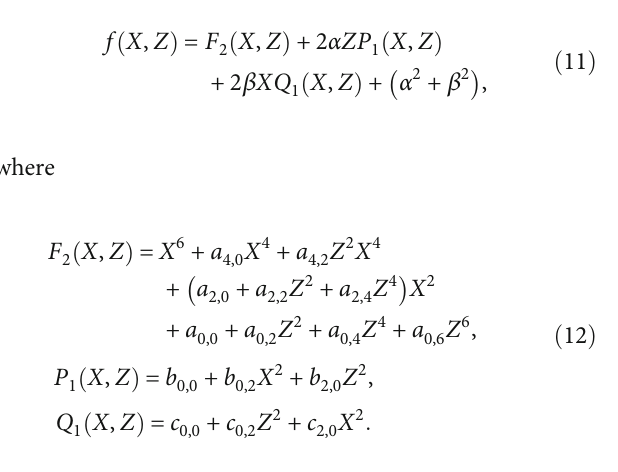
Figure 2: The 3-lump solution u of Equation (1) with the parameter selections m = − 3, n = 2, c = 1, u b = 1 . (a) Perspective view of the wave u ð X , Z Þ , (b) overhead view of the wave u ð X , Z Þ , and (c) the corresponding contour plot 0,2 u ð X , Z Þ